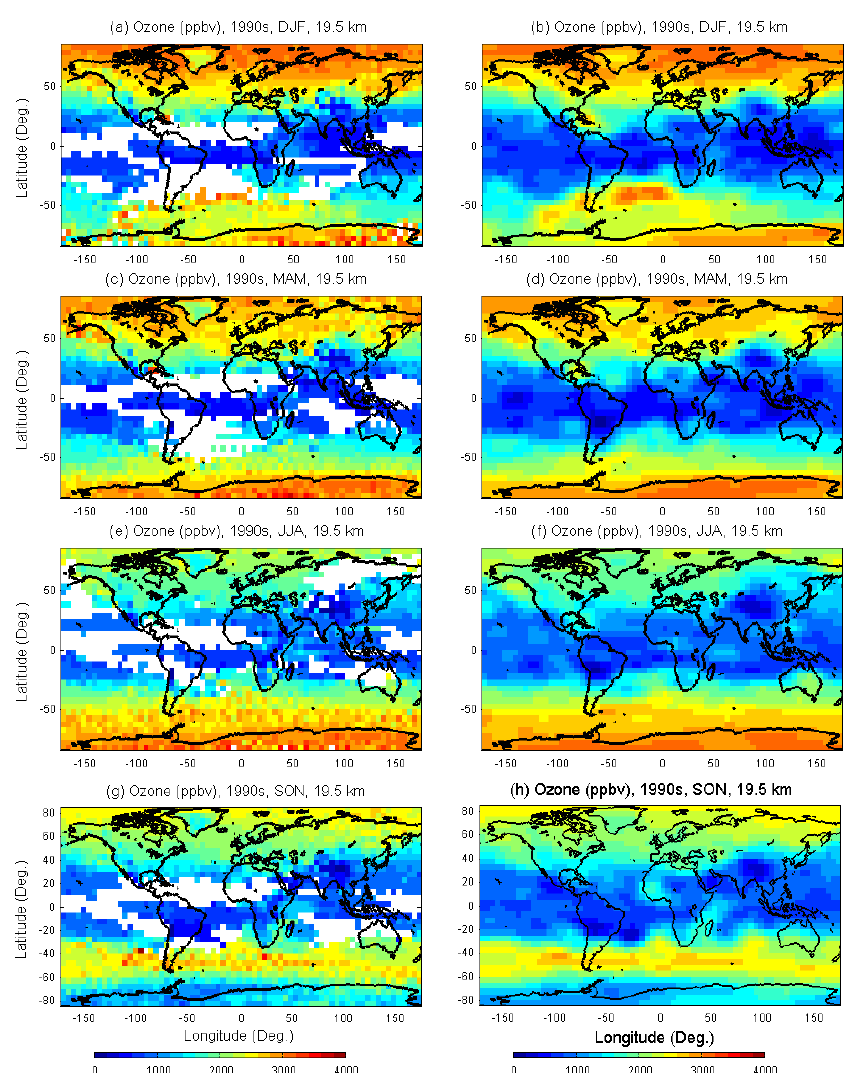
Fig. 13. Ozone fields with gaps (white areas) in the NH winter (DJF), spring (MAM), summer (JJA), and fall (SON) at 19.5 km in the 1990s (left panels) and the corresponding smoothed ozone fields (right panels).